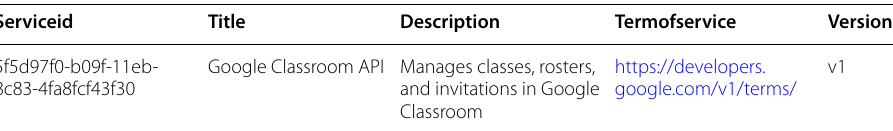
Table 4 Record in service